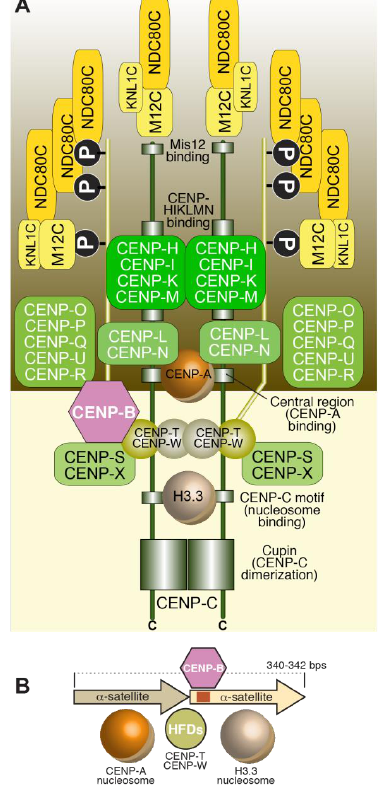
Figure 8. A model for the assembly unit of the human kinetochore. The kinetochore assembly unit is depicted as being organized on a CENP-A-H3.3 dinucleosome. ( A ) A primary determinant of the